Question: Author a descriptive caption for the visualization shown.
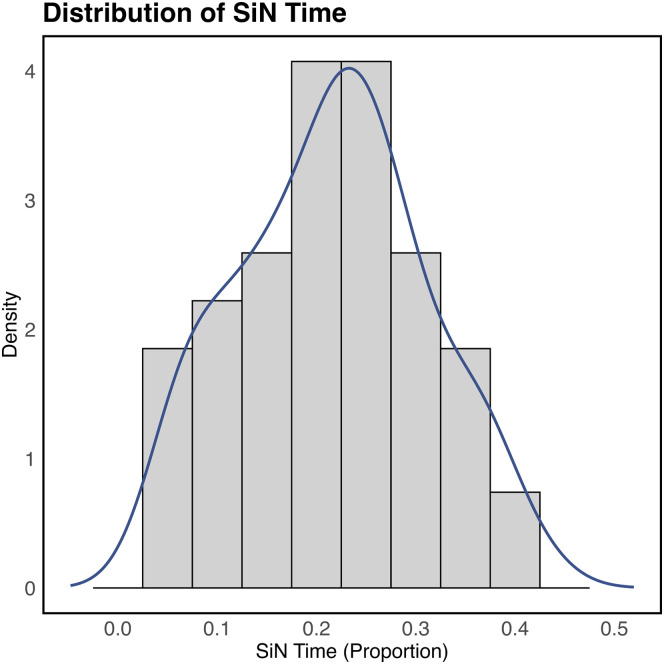
Answer: Histogram with probability density function of proportions of time spent in speech in noise (SiN) across participants. Bin width is 0.05 (5%).